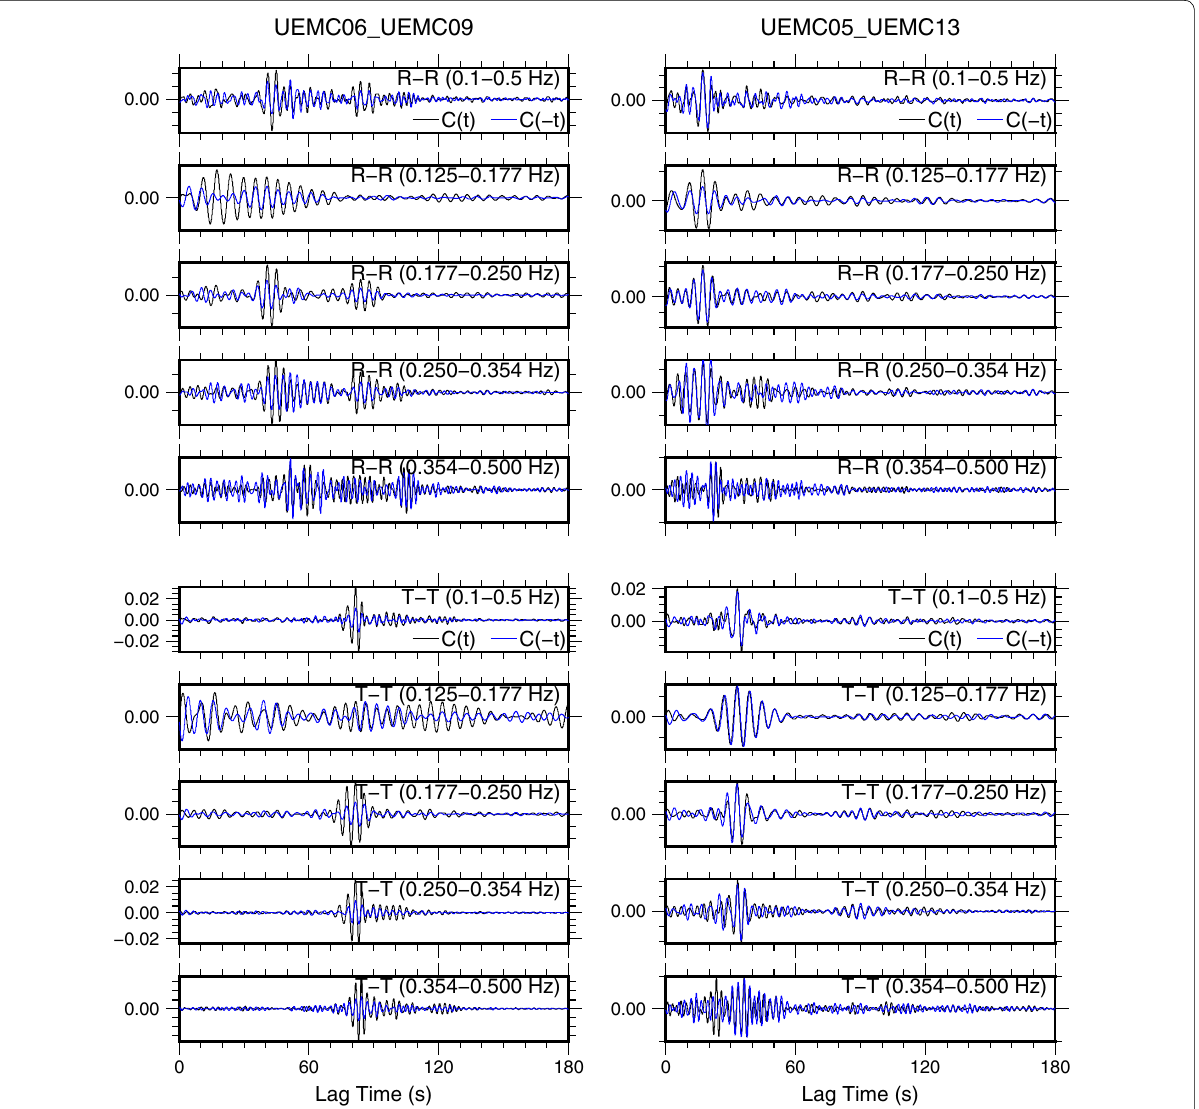
Fig. 5 Comparison of the causal and acausal parts of the obtained inter-station cross-correlation functions for two station pairs (UEMC06–UEMC09 and UEMC05–UEMC13). Black and blue traces represent the causal and acausal parts, respectively. The R – R and T – T components in five different frequency ranges are